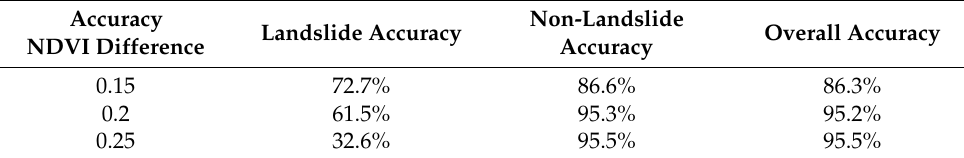
Table 7. Overlapping results, Typhoon Morakot and the 2009 Landslide